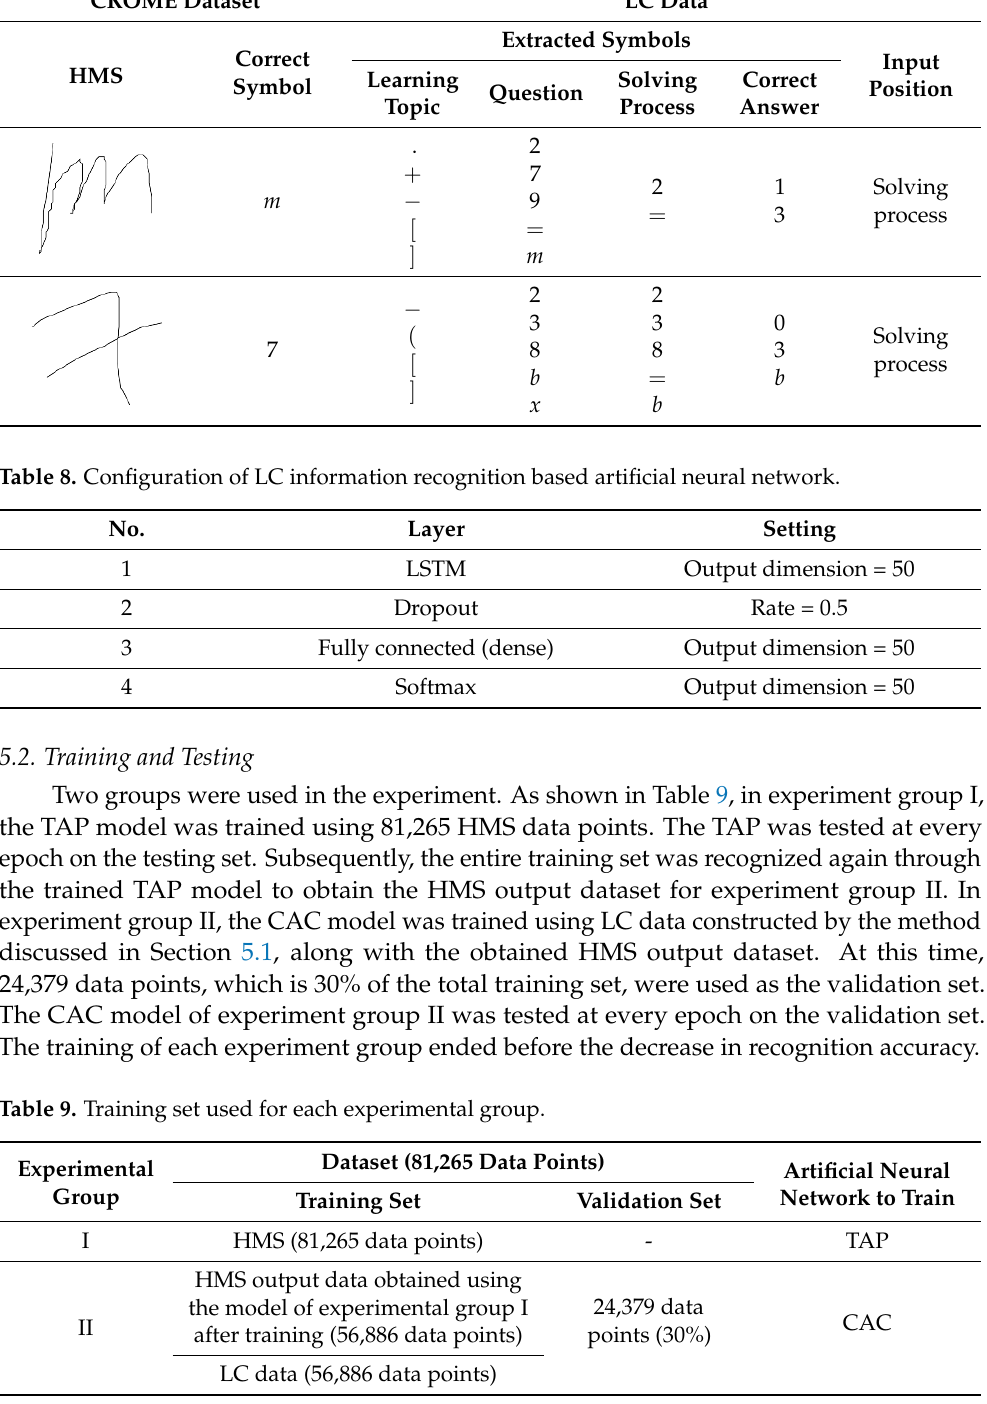
Table 7. Sample data points assigned LC data.